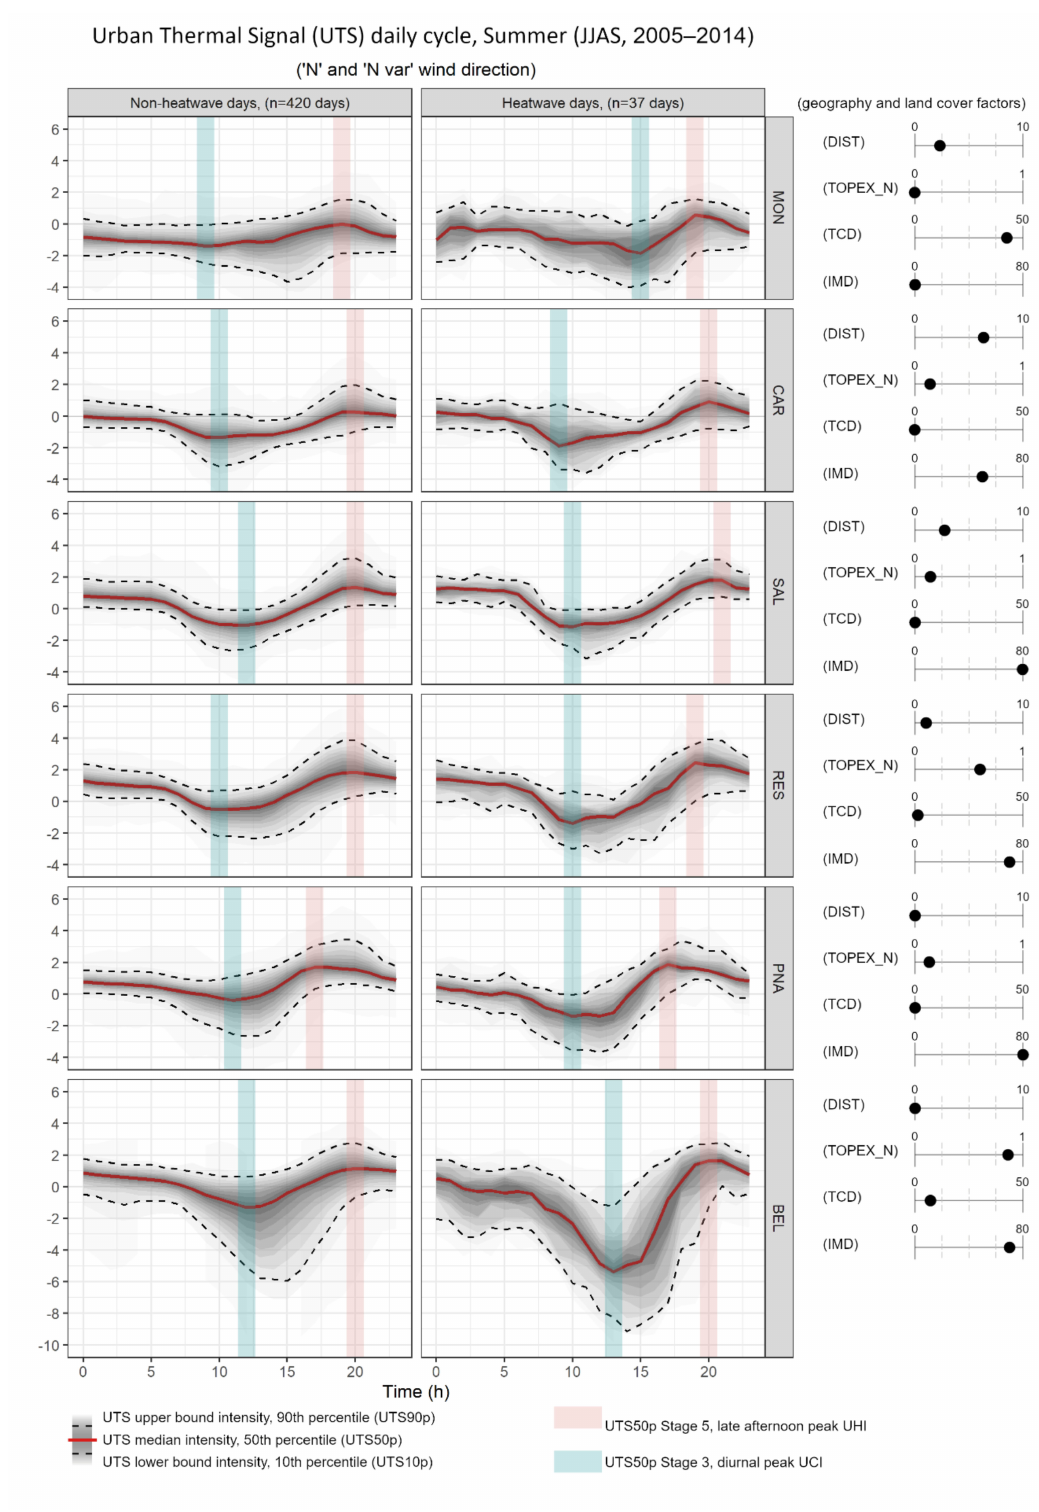
Figure 6. The statistical distribution of the hourly urban thermal signal (UTS) intensities, per site, during heatwave (HW) and non-heatwave (non-HW) conditions: solid lines represent the median hourly UTS intensities (UTS50p), dashed lines represent the 10th and 90th percentile curves (UTS10p and UTS90p, respectively), and the grey gradient depicts the statistical spread by 0.5 probability intervals. Vertical shaded areas correspond to the UTS50p daily minimum (blue, or dark grey) and maximum (red, or light grey). On the righthand side, schematic plots illustrate the characteristics of each site, which were mentioned in Table 1 and Figure